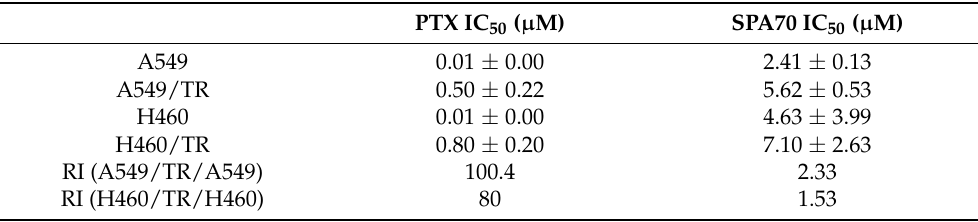
Table 1. IC 50 of PTX and SPA70 against human NSCLC cell lines (mean ± SEM, n = 4).